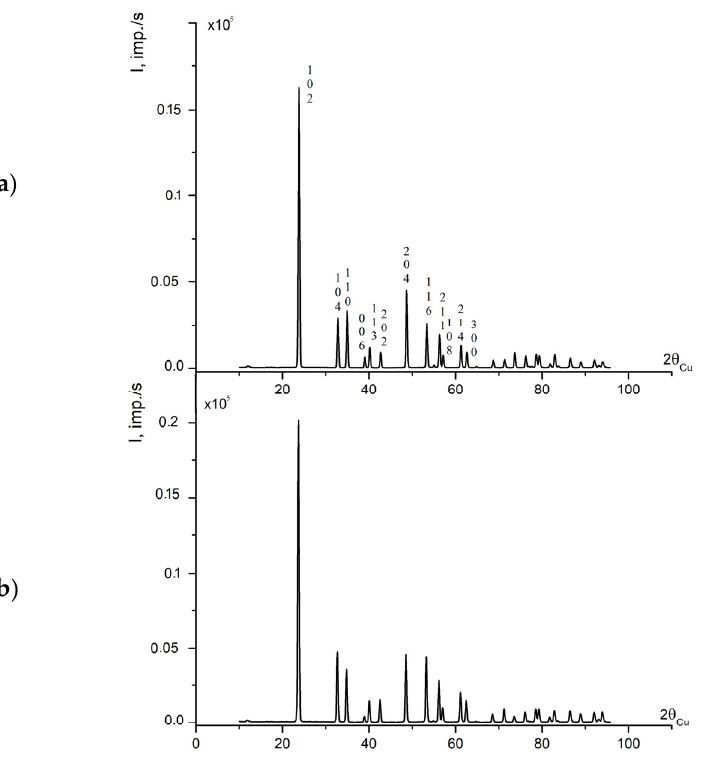
Figure 6. X-ray diffraction patterns of powdered sample 2 ( a ) and sample 1 ( b ). Table 3. Unit cell parameters of NSLN K 2 O, CLN and samples 1 and 2.